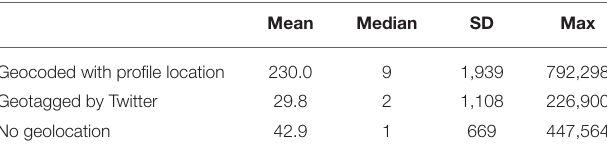
TABLE 3 | Number of tweets per user from October 15, 2018, to October 14, 2021. Retweets and tweets from verified accounts are